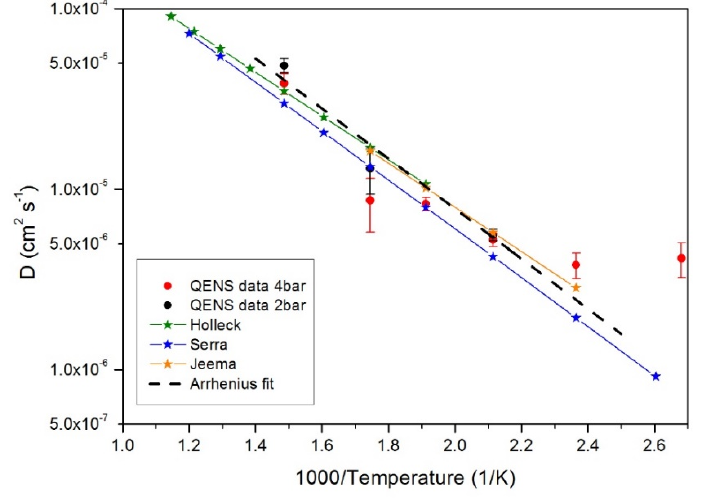
Figure 9. Macroscopic (full stars plus line) diffusion coefficients from Refs. [62] (green), [51] (blue), and [63] (orange) compared to QENS microscopic diffusion coefficients (full dots) at 2-bar loading (black) and 4-bar loading (red).